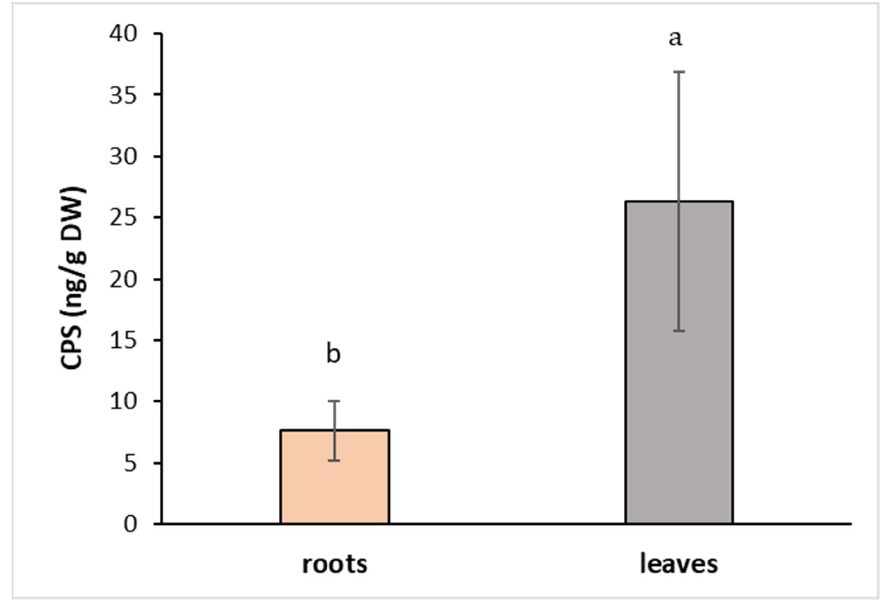
Figure 2. Content of CPS in hybrid aspen growing on medium supplemented with CPS at a concen- tration of 1 mg L − 1 . Samples were collected after 7 days of cultivation. Data represent the mean ± S.D. ( n = 4). Different letters mean statistically significant differences ( p ≤ 0.05).